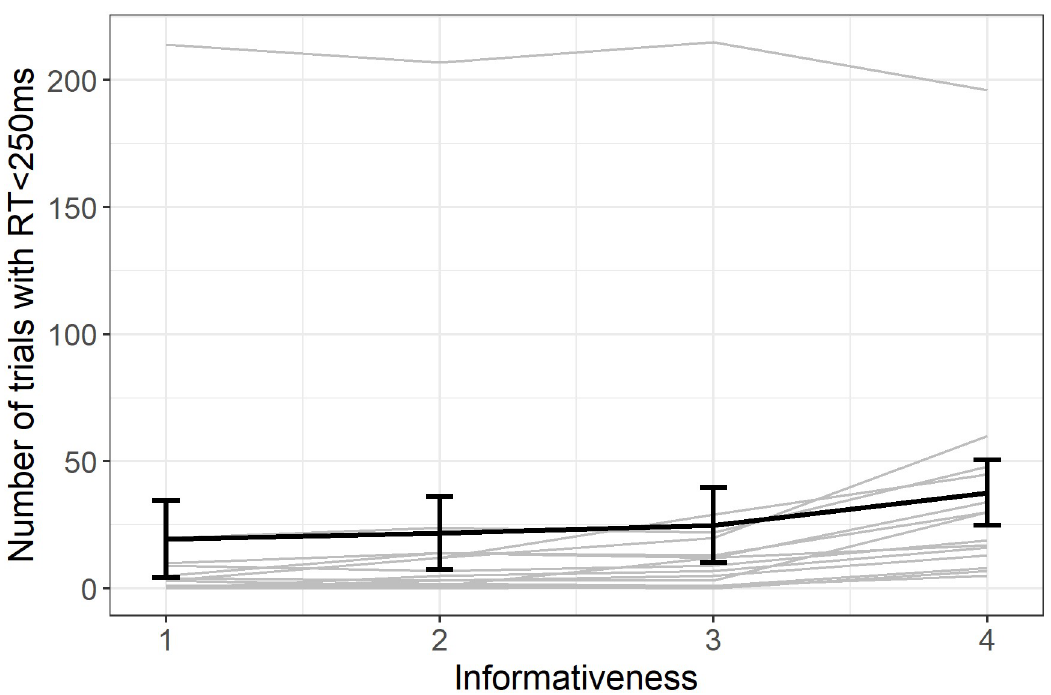
Fig 5. Number of fast responses (RT < 250ms) with informativeness. Individual responses (light grey) with group average (error bars represent standard error).